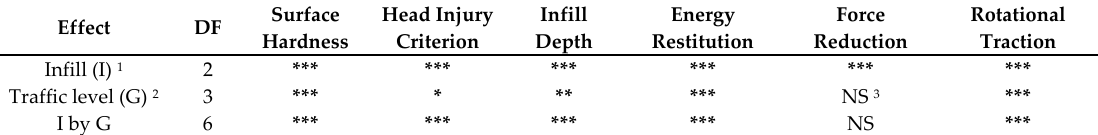
1 Three different infills: 1. thermoplastic elastomer, coconut and cork mixture, and recycled shoe rubber. 2 Traffic levels of 0, 12, 65, and 120 games. 3 NS, not significant at the P ≤ 0.05 level. * Significant at the 0.05 probability level. ** Significant at the 0.01 probability level. *** Significant at the 0.001 probability level.